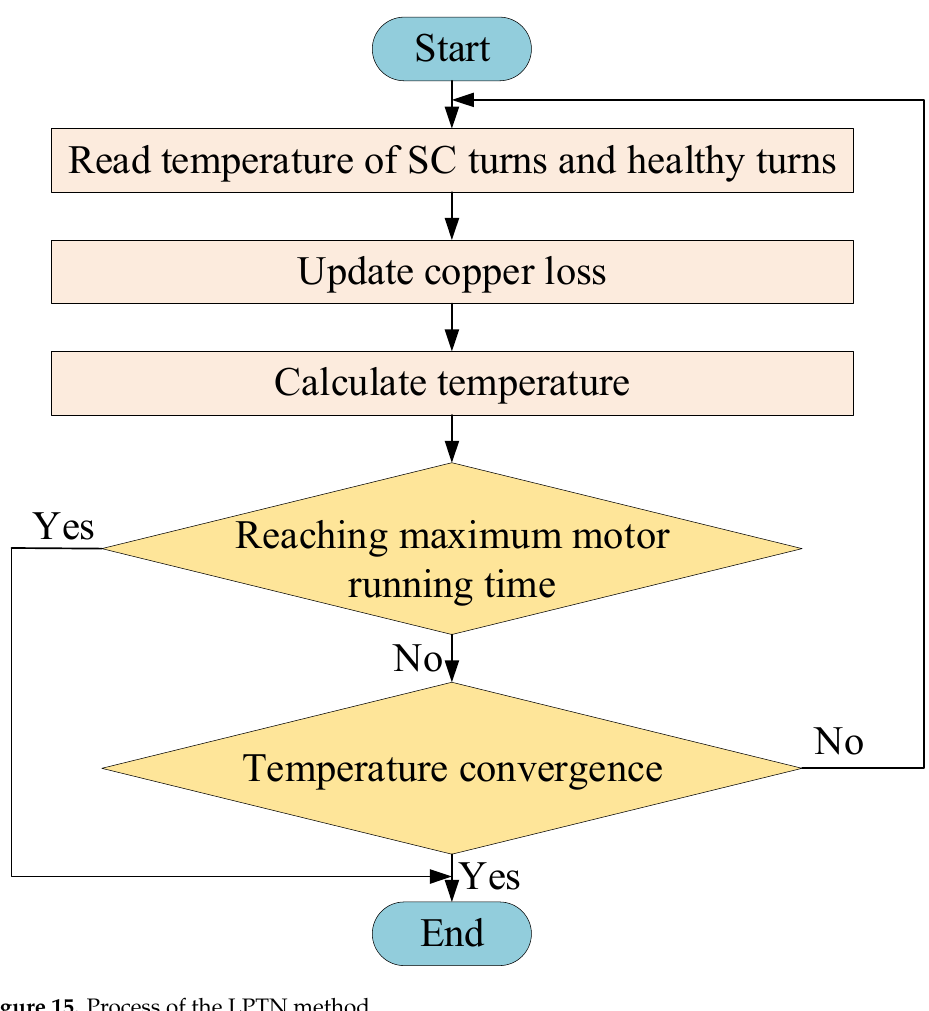
Figure 15. Process of the LPTN method.